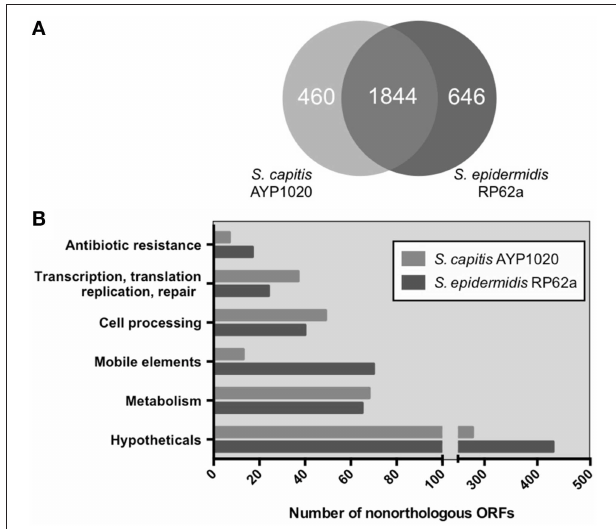
FIGURE 3 | Orthologous classification of CDS of S. capitis AYP1020 compared to S. epidermidis RP62a. Orthologs were defined by bidirectional BLASTp with an e -value cut off of 10e-30 (A) . Non-orthologous CDS were grouped based on COG functional categories (B) .